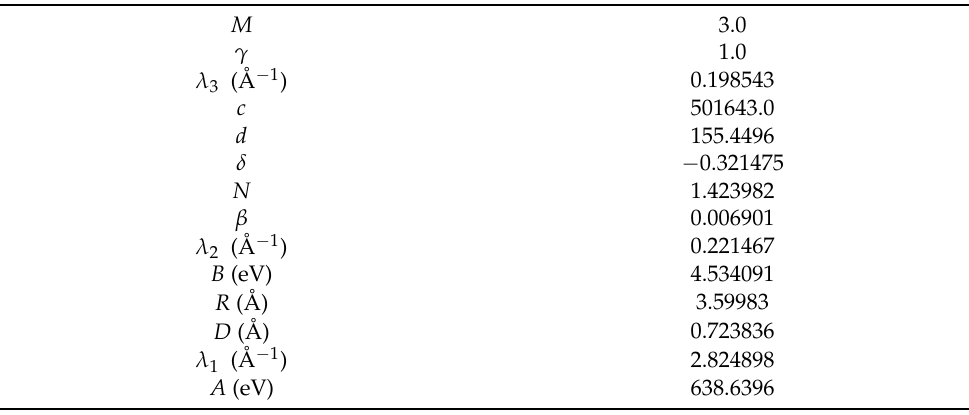
Table 1. Parameters of the Tersoff potential